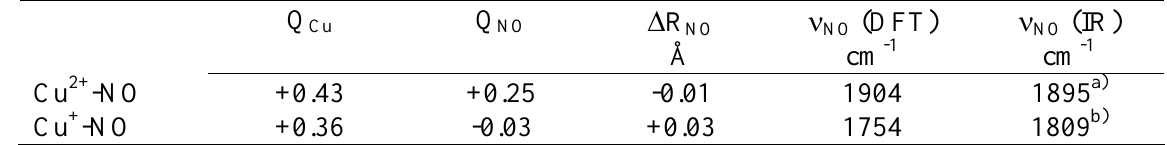
Table 4 . Effect of NO interaction with CuZSM-5: charge on copper cation and adsorbed NO, changes in NO bond lengths ( ∆ R ), calculated and measured NO stretching frequency ( ν NO